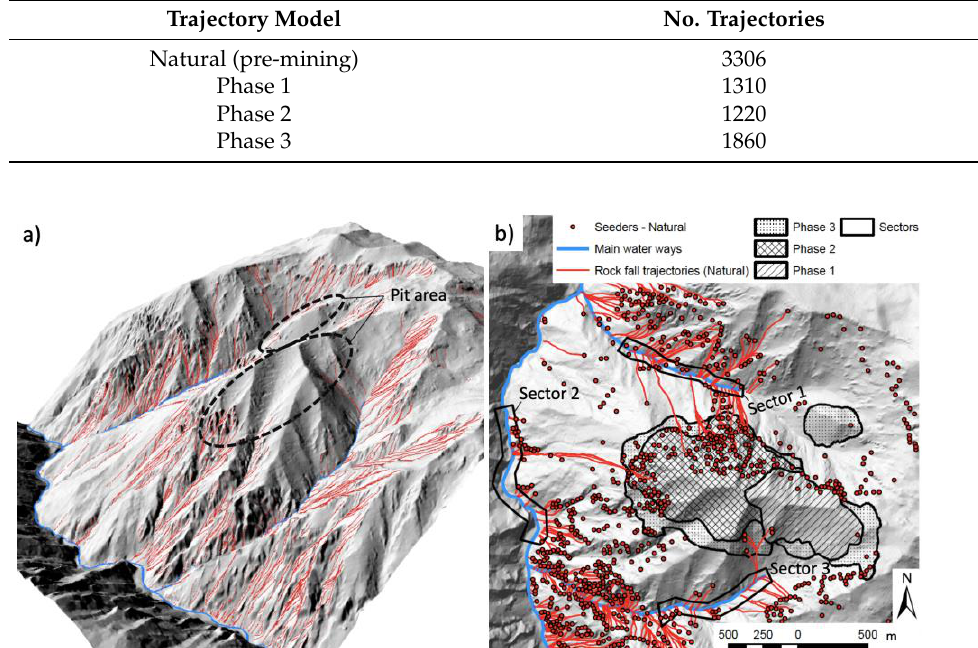
Table 4. Trajectories per simulation.